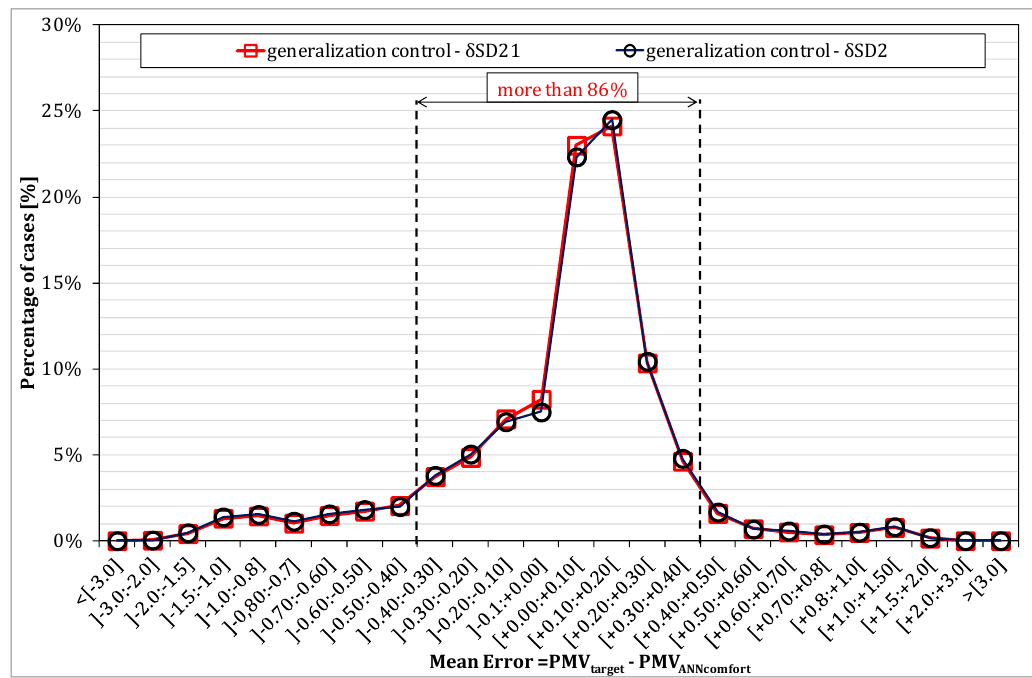
Figure 7. Neural Network generalization control: PMV mean error range returned by the ANN.